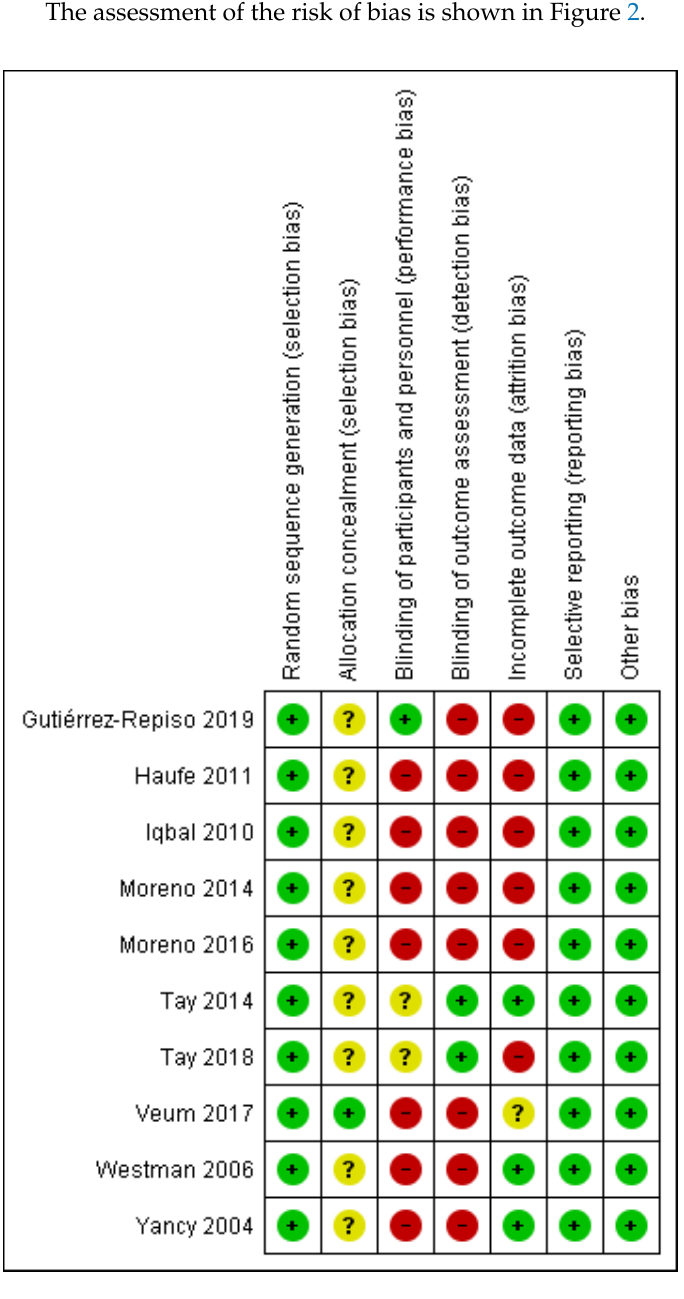
Figure 2. Assessment of the risk of bias of the ten RCT included in this SR. Green: low risk of bias; yellow: unclear risk of bias; and red: high risk of bias.